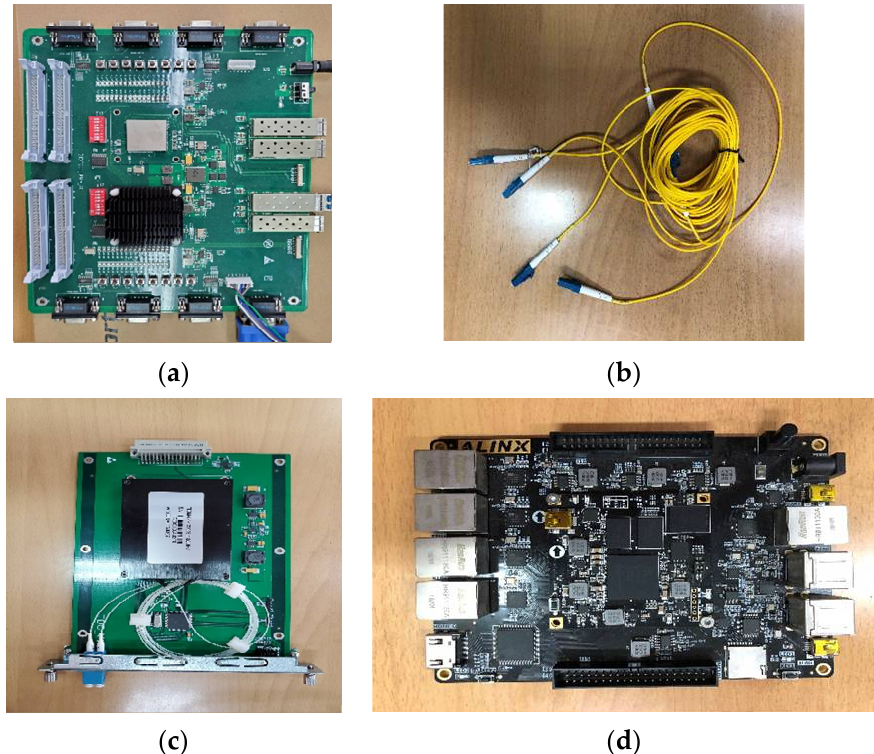
Figure 15. Object diagram include ( a ) optical transceiver monitoring module; ( b ) optical fiber; ( c ) CD regulator and ( d ) analog photodetector of main experiments of the dispersion monitoring system for the OOK signal .